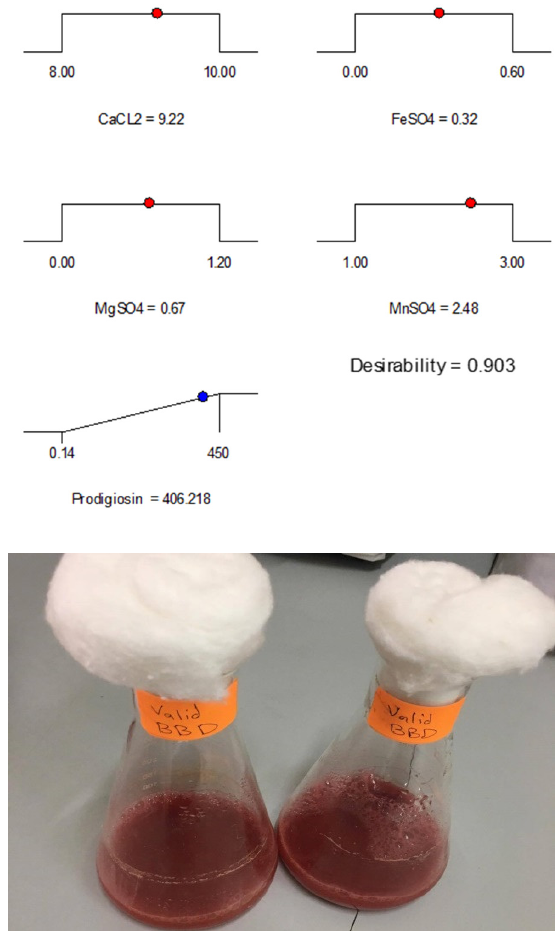
Fig. 7. ramp chart for numerical optimization condition of prodigiosin based on Box –Behnken design matrix